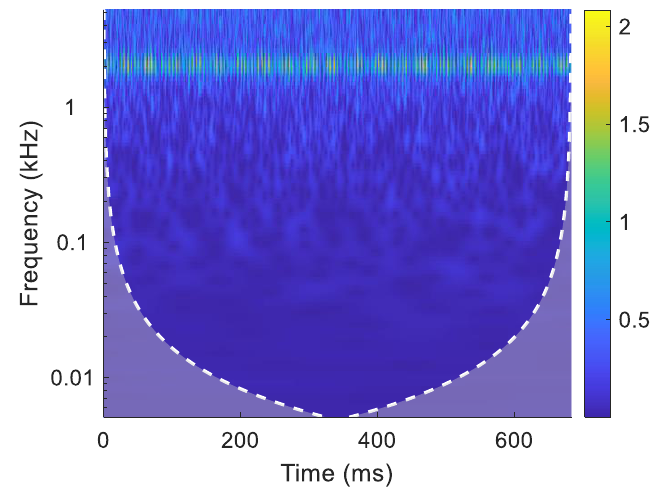
Figure 7. Wavelet transform of the simulated signal.